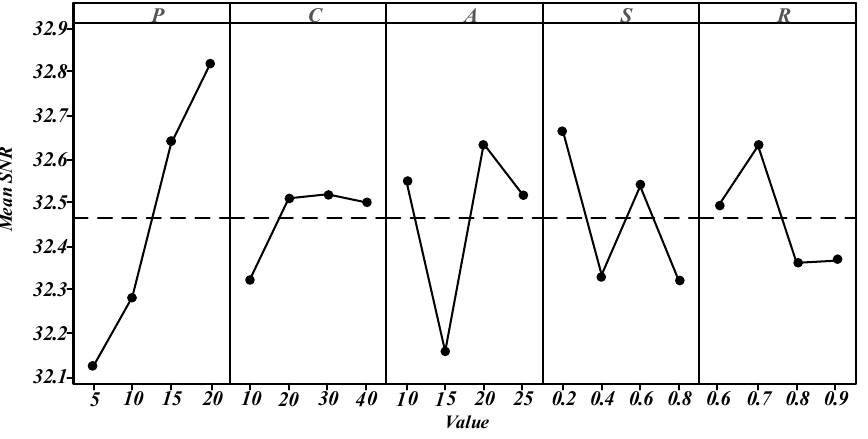
Figure 5. SNR main effects plot.